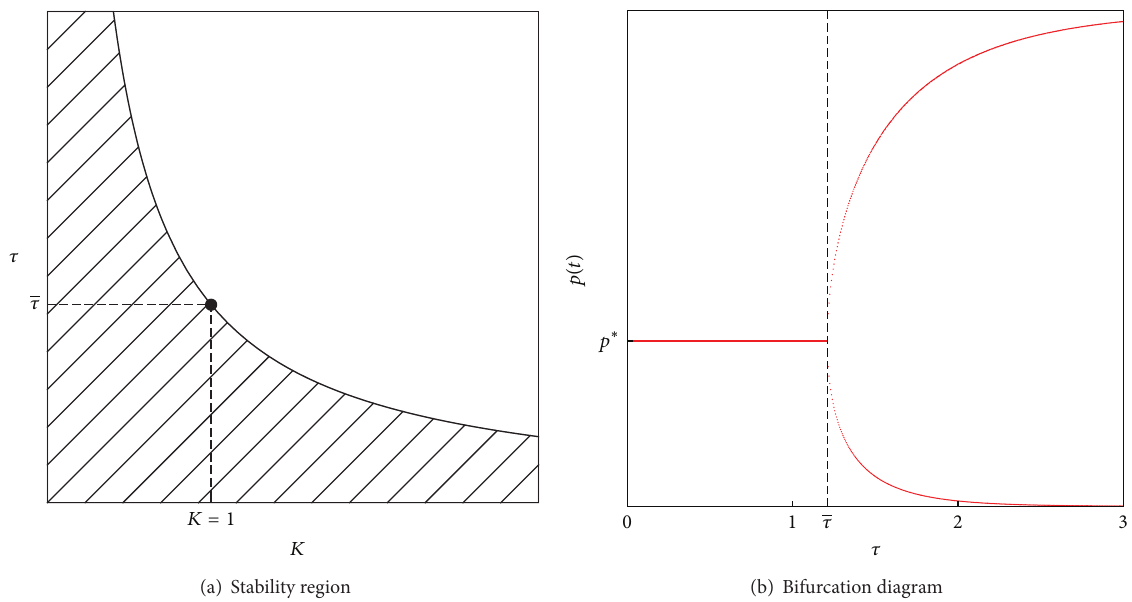
Figure 1: Numerical results on one-delay model